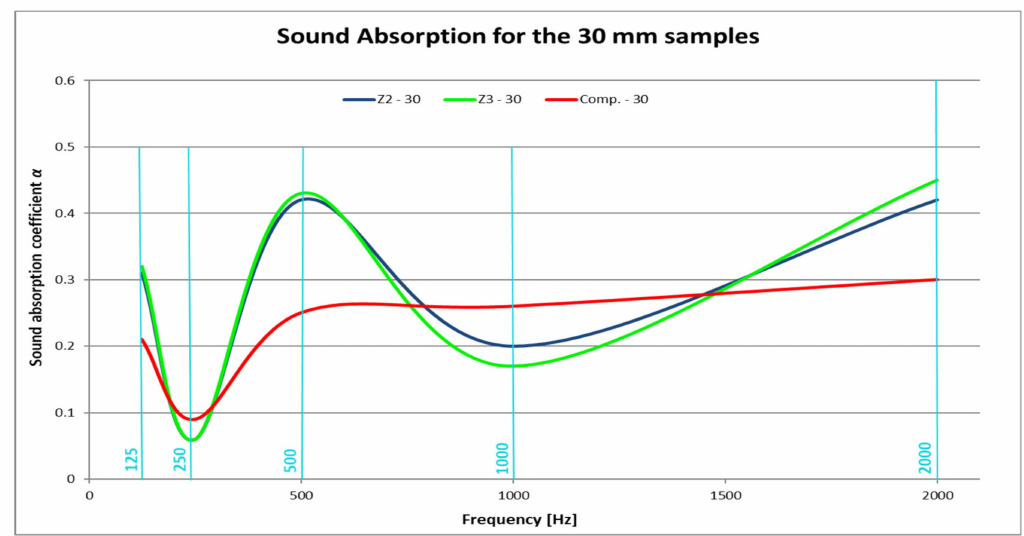
Figure 7. Sound absorption of cement composites (thickness 30